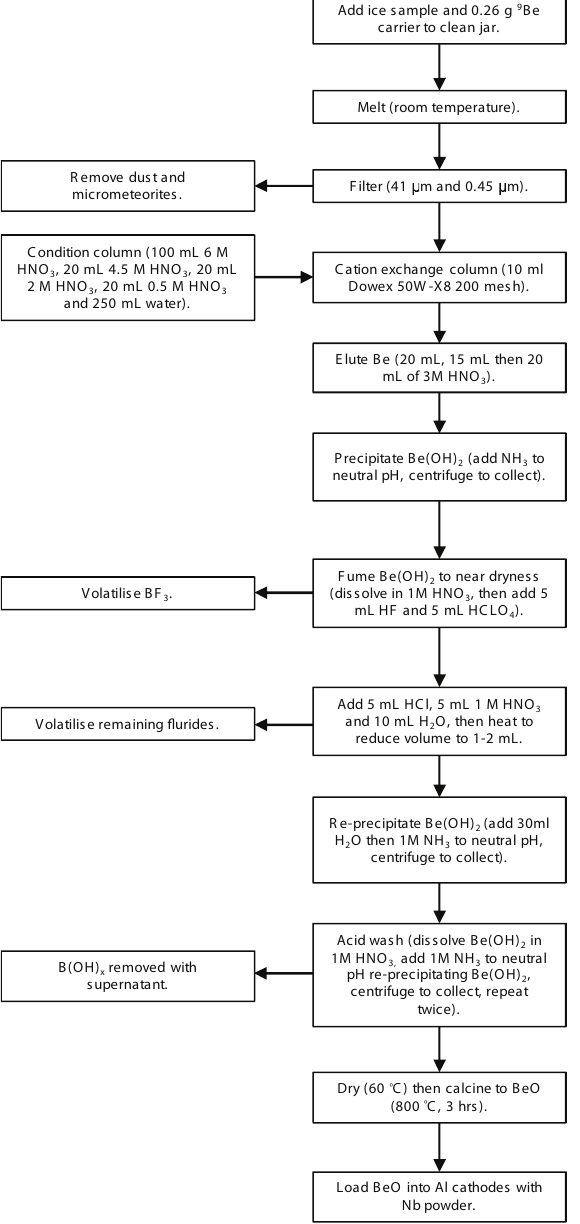
Fig. 2. Flowchart showing the procedure used for extracting 10 Be from ice samples for AMS